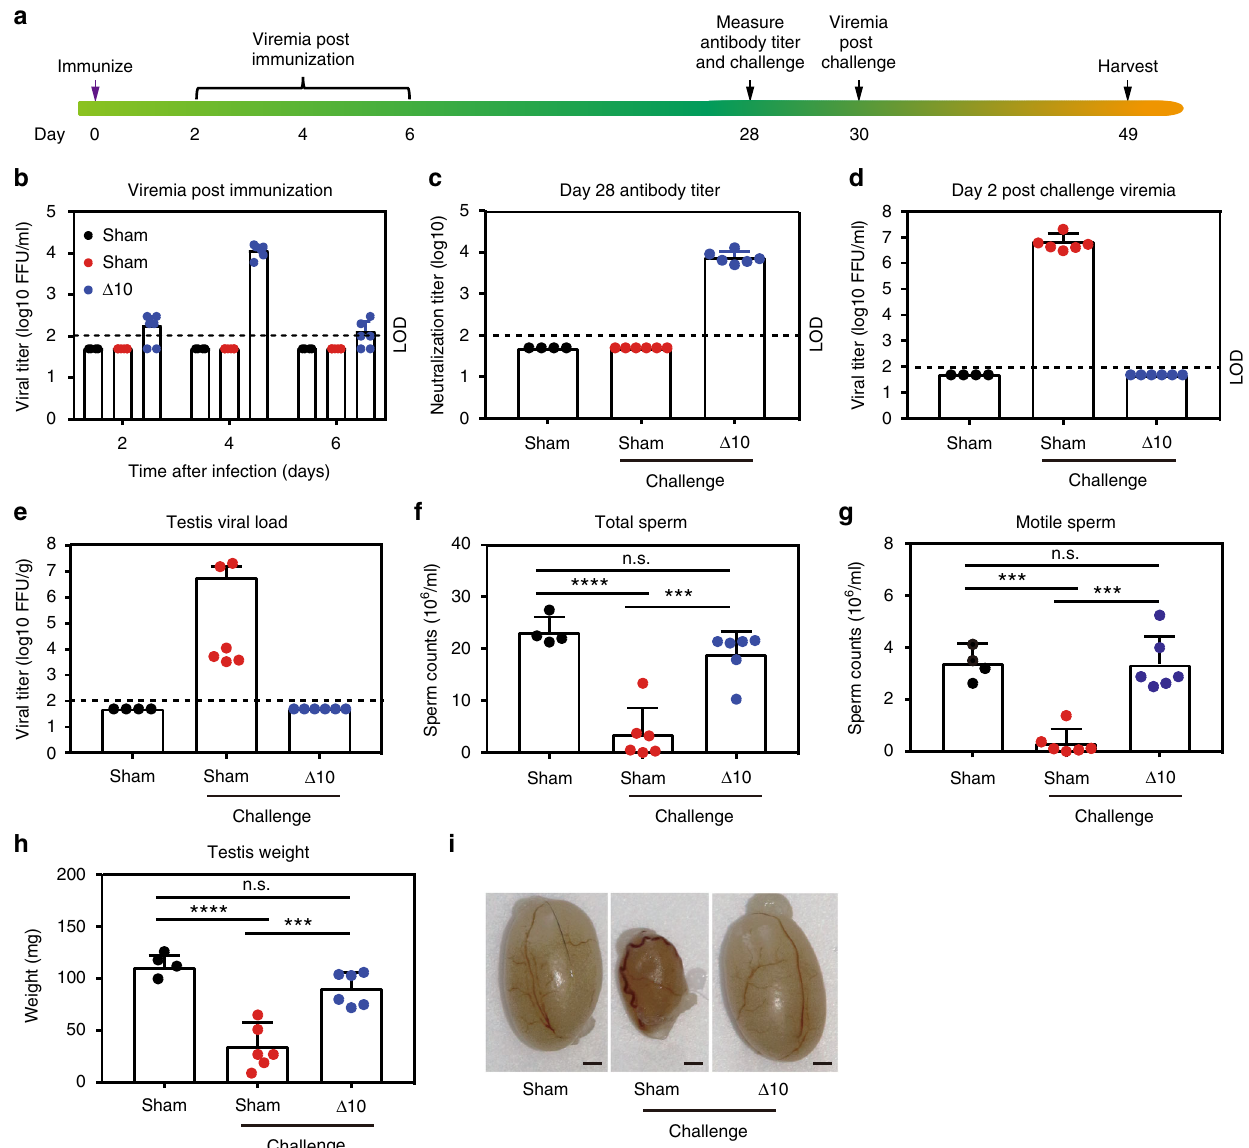
Fig. 2 ZIKV-3 ′ UTR- Δ 10-LAV protects young A129 male mice against testis infection and injury. a Scheme of immunization of 3-week-old A129 male mice with 10 4 FFU of ZIKV-3 ′ UTR- Δ 10-LAV ( Δ 10; n = 6) or PBS sham ( n = 4 or 6). At day 28 post immunization, mice were measured for neutralization antibody titers. On the same day, mice from one sham group and mice from Δ 10-immunized group were challenged with 10 6 FFU of ZIKV-PRVABC59, and viremia was measured at day 2 post challenge (day 30 post immunization). At day 49 post immunization, mice were analyzed for sperm counts and viral load in the testis. b Viremia after immunization with Δ 10 vaccine candidate. c NT 50 values of antibody neutralization at day 28 post immunization were measured for individual animals in each group. The dashed lines indicate the limit of detection (LOD) of the assay. d Viremia at day 2 post challenge (day 30 post immunization) with ZIKV PRVABC59. e Viral load in the testis at day 21 post challenge (day 49 post immunization). f , g Total ( f ) and motile ( g ) sperm counts at day 21 post challenge. h , i Testis weight ( h ) and representative images of testis ( i ) from animals from sham, sham with challenge, and Δ 10-immunized and challenged groups at day 21 post challenge. Scale bar , 1mm. Asterisks indicate signi fi cant differences (one-way ANOVA: **** P- value < 0.0001; *** P -value < 0.001). Nonsigni fi cant (n.s.), P -value > 0.05. All negative samples are plotted at the half value of LOD. Error bars represent Results Prevention of vertical transmission in pregnant mice .